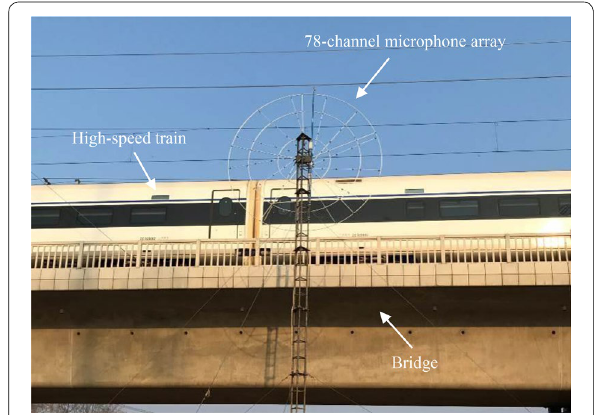
Figure 1 Measurement photograph of the exterior noise source identification of a high-speed